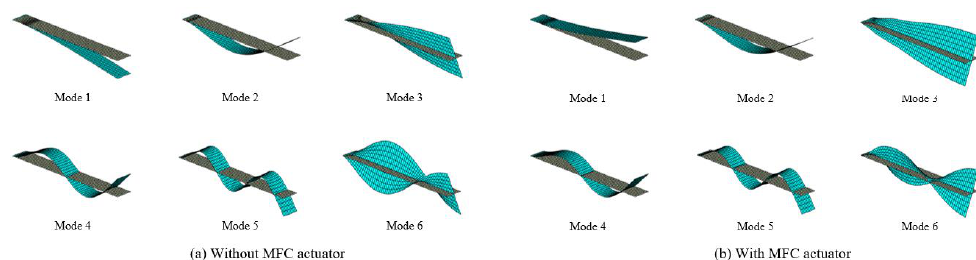
Figure 8. Structural modal shapes. ( a ) Structural modal shapes without MFC actuators; ( b ) structural modal shapes with MFC actuators.